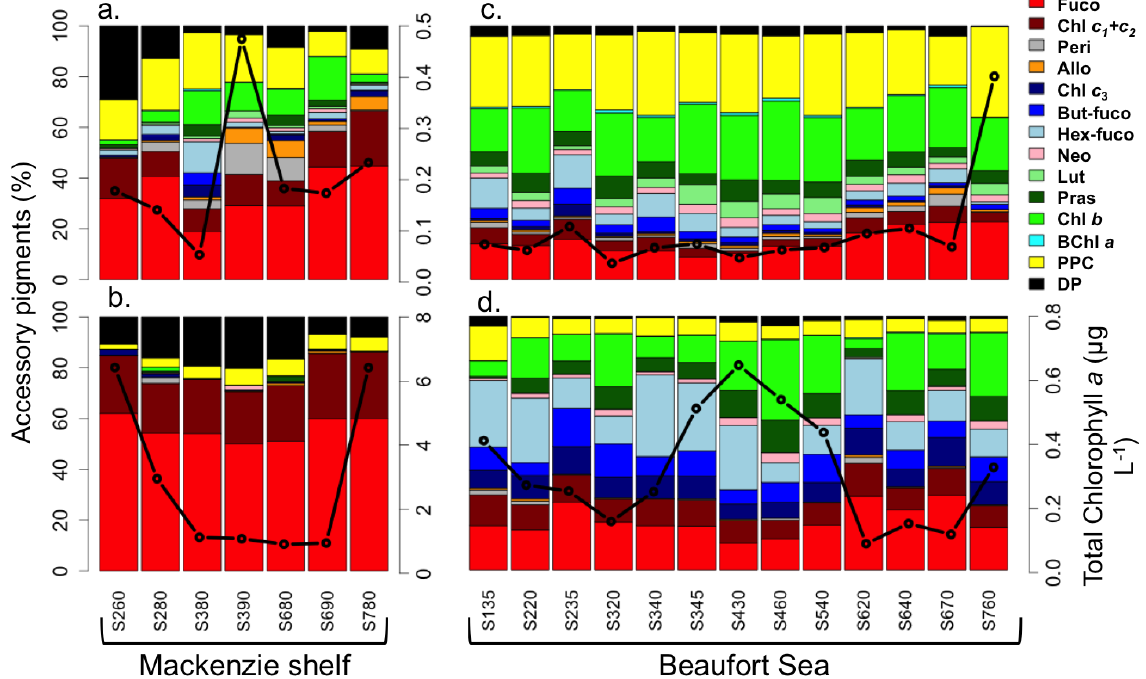
Figure 2. Relative contribution of accessory pigments to total accessory pigment (wt:wt) in (a, c) surface water and at the (b, d) subsurface chlorophyll maximum (SCM) depth of the (a, b) Mackenzie shelf and (c, d) deep waters of the Beaufort Sea. The black line with circle represents the chlorophyll a concentration. DP: degradation pigments (Chlide a + Pheide a + Phe a ); PPC: photoprotective carotenoids (i.e., Diadino + Diato + Zea + Viola + Car). Pigment abbreviations are defined in Table 1. Please note the different TChl a scales between the four panels. The same TChl a scale (0–0.8µgL − 1 ) was used for the panels (c) and (d)